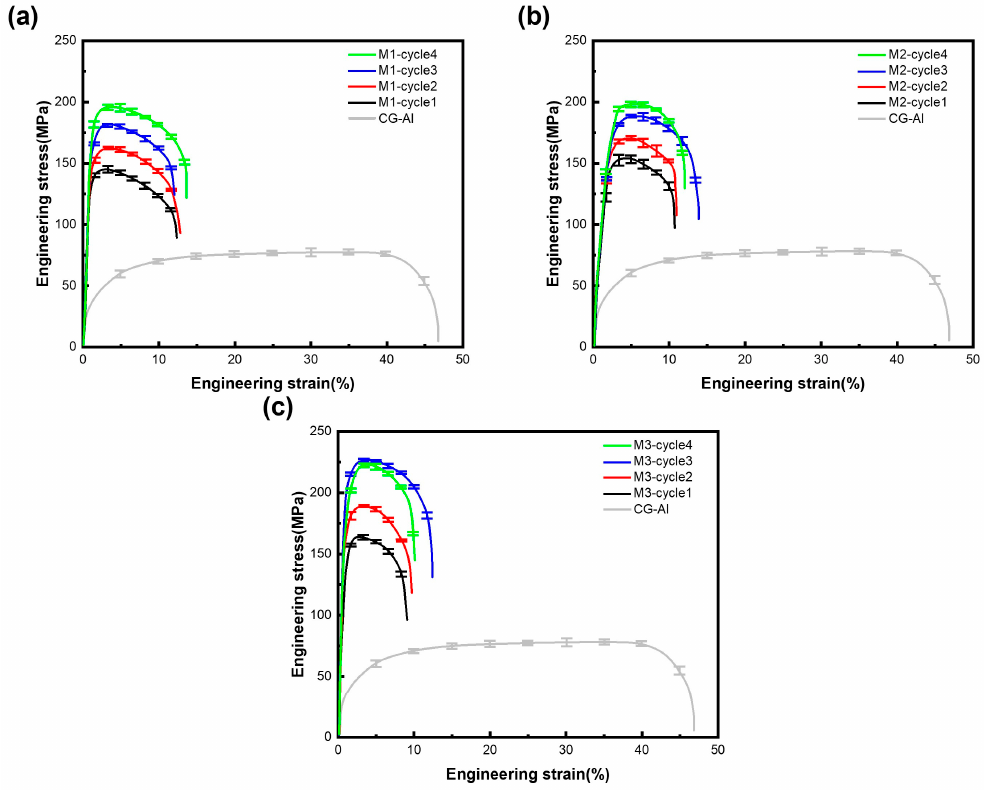
Figure 9. Diagram showing the engineering stress–strain for ( a ) M1, ( b ) M2 and ( c ) M3 after different cycles of MARB. Table 2. Summary of mechanical properties reported by similar research.